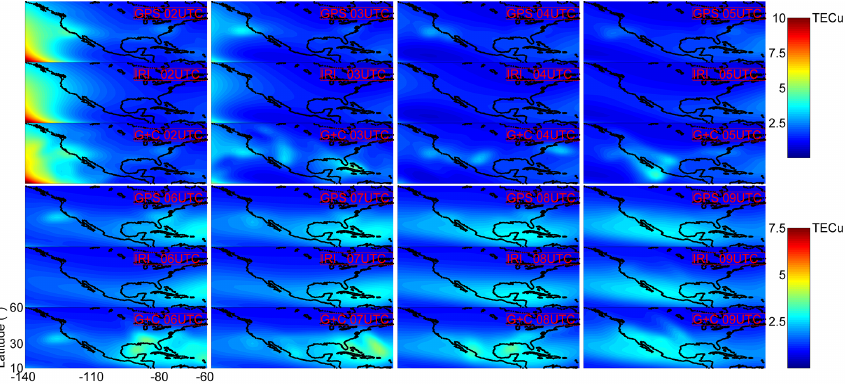
Figure 5. The DA and background model IRI TEC map of the North American Continent at nighttime (02:00 to 05:00UTC, top three rows) and 06:00 to 09:00UTC (bottom three rows). Each time period has three different TEC maps, including a DA TEC map using ground-based GPS data, an IRI TEC map, and a DA TEC map using ground-based GPS and F3/C RO